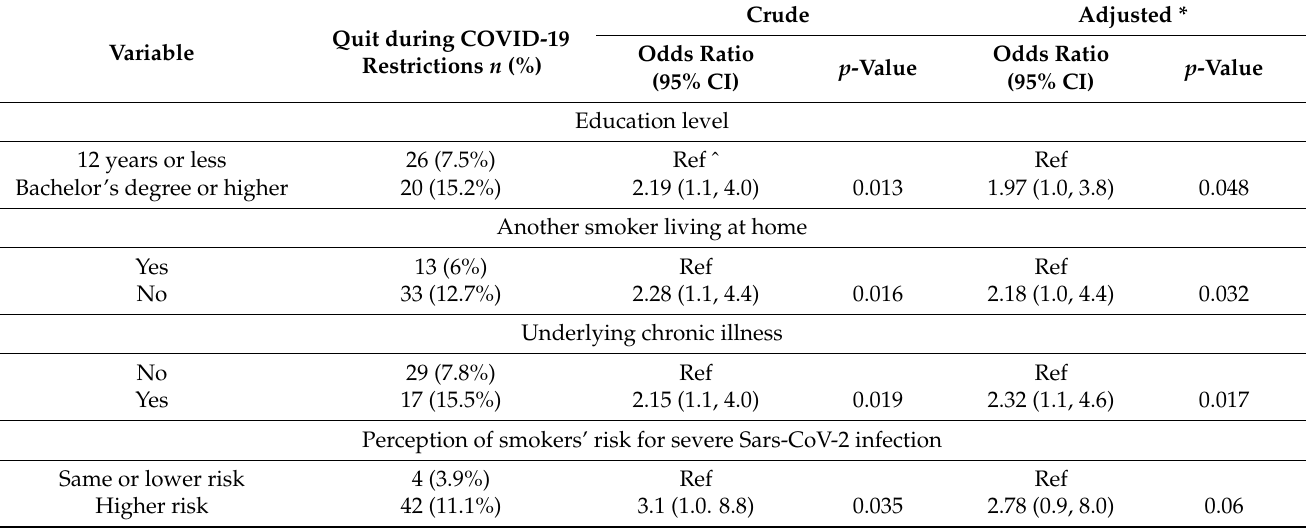
Table 4. Factors associated with quitting during the COVID-19